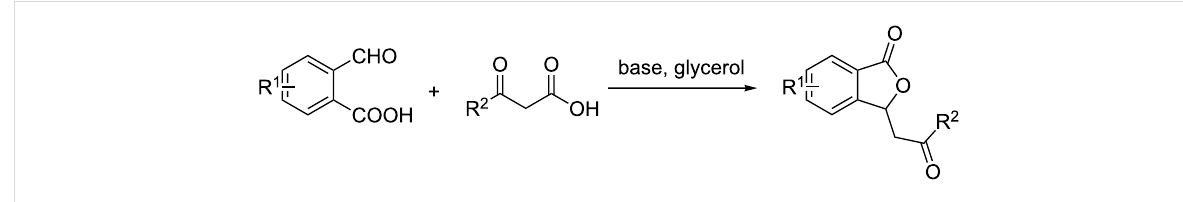
Scheme 1: Synthesis of 3-substituted phthalides from substituted 2-formylbenzoic acids and β -keto acids.